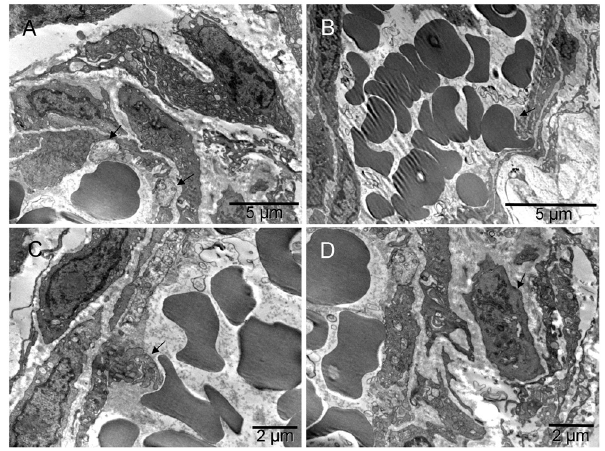
Figure 12. Ongoing structural rearrangements in the less advanced region of the forming artery (I). The images were from a section parallel to the one shown in Figure 11, i.e. from another region of the same vessel. Arrows point to two chromaffin cells in [ A ]; erythrosome, platelets and maturing platelets “ ante portem ”, i.e. facing opening in the endothelium, are shown in [ B , C & D ], respectively.